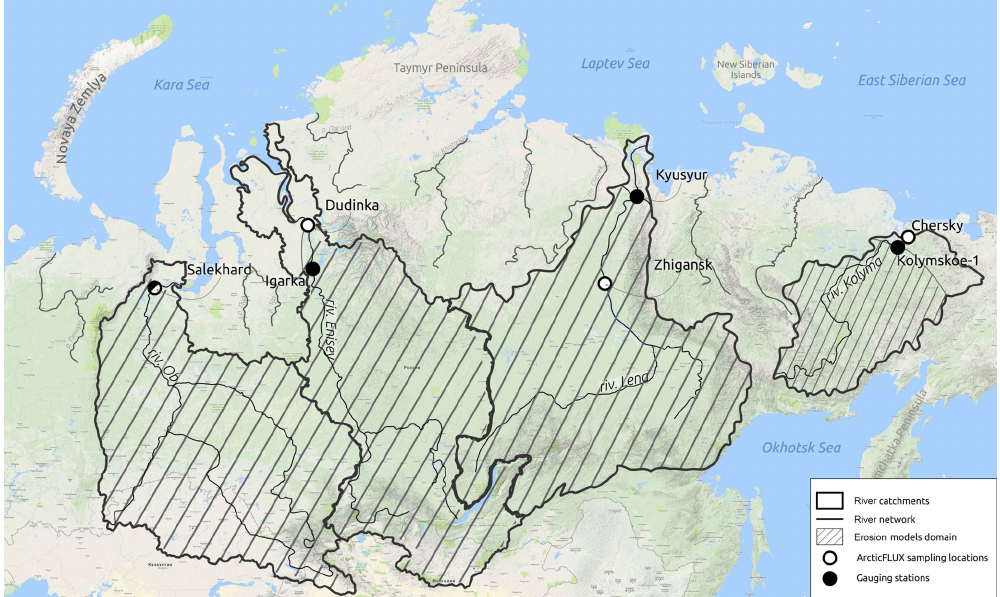
Figure 7. Map delineating great Siberian rivers studied in the ArticFLUX project under the PEEX umbrella to monitor erosion and biogeo- chemical fluxes into the Arctic